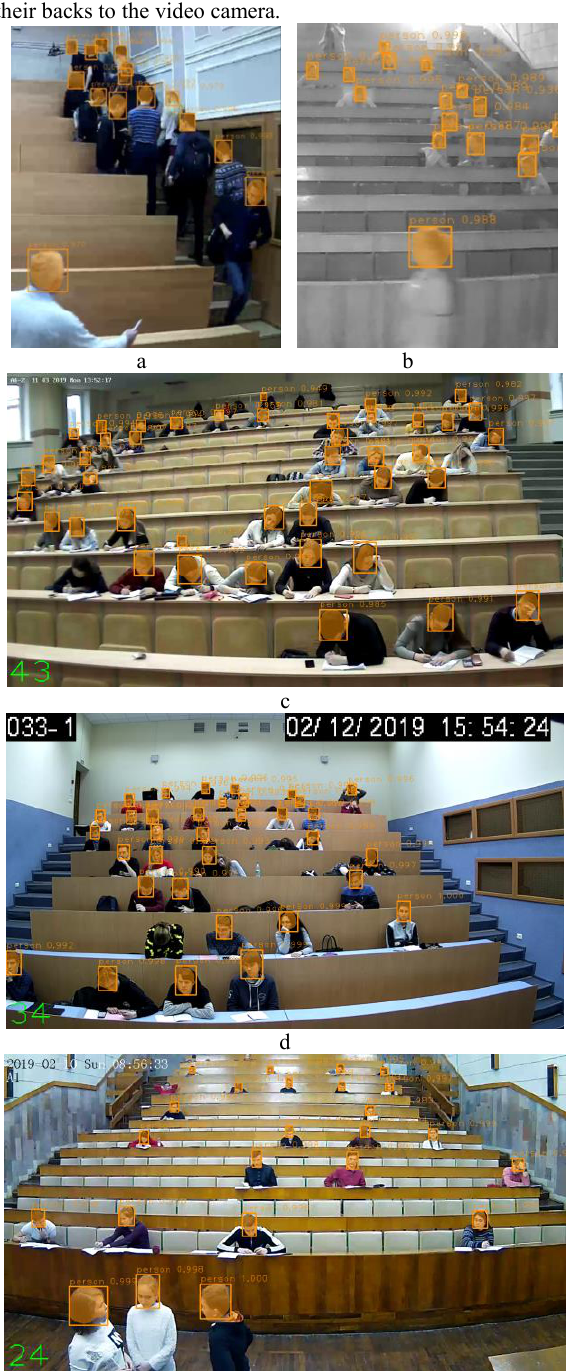
Figure 6. The structure of the developed software for human heads detection Figure 7. Examples of human heads detection in classrooms of BSTU n. a. V.G. Shukhov with developed